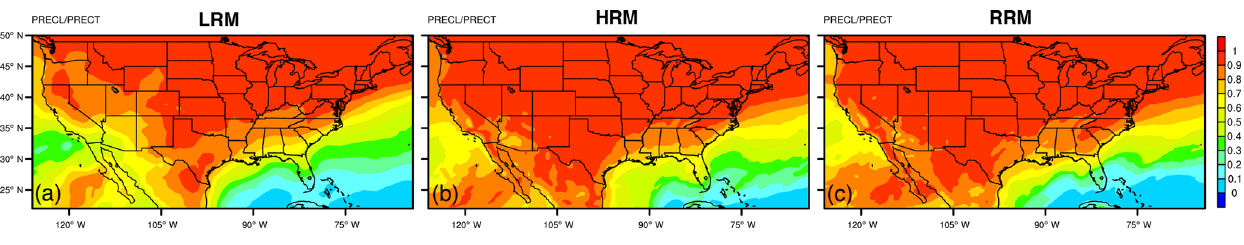
Figure 13. Same as Fig. 12, but for